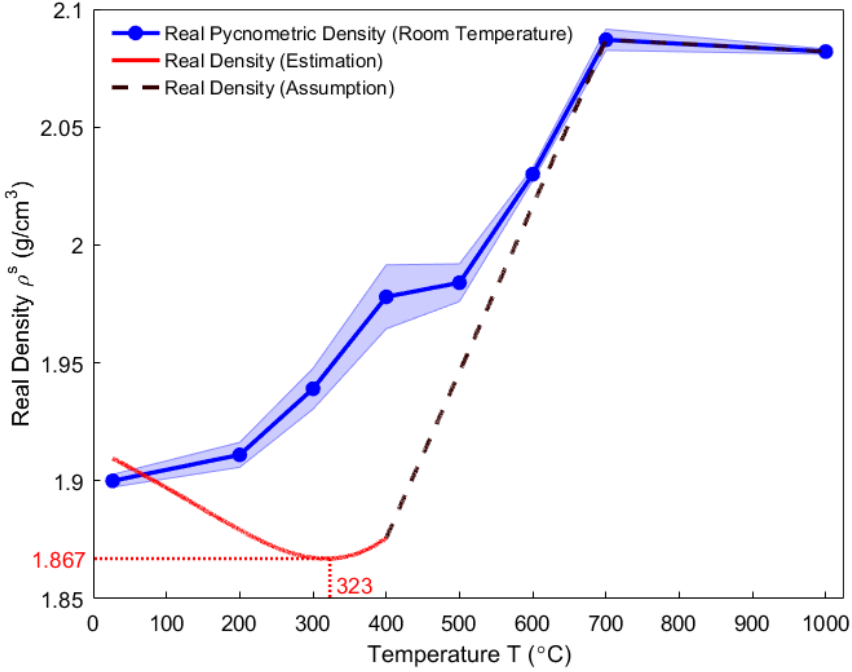
Figure 6. Real pycnometric density measured at room temperature and real density at high temperatures. The red solid line and the brown dashed line shown in Figure 6 represent,